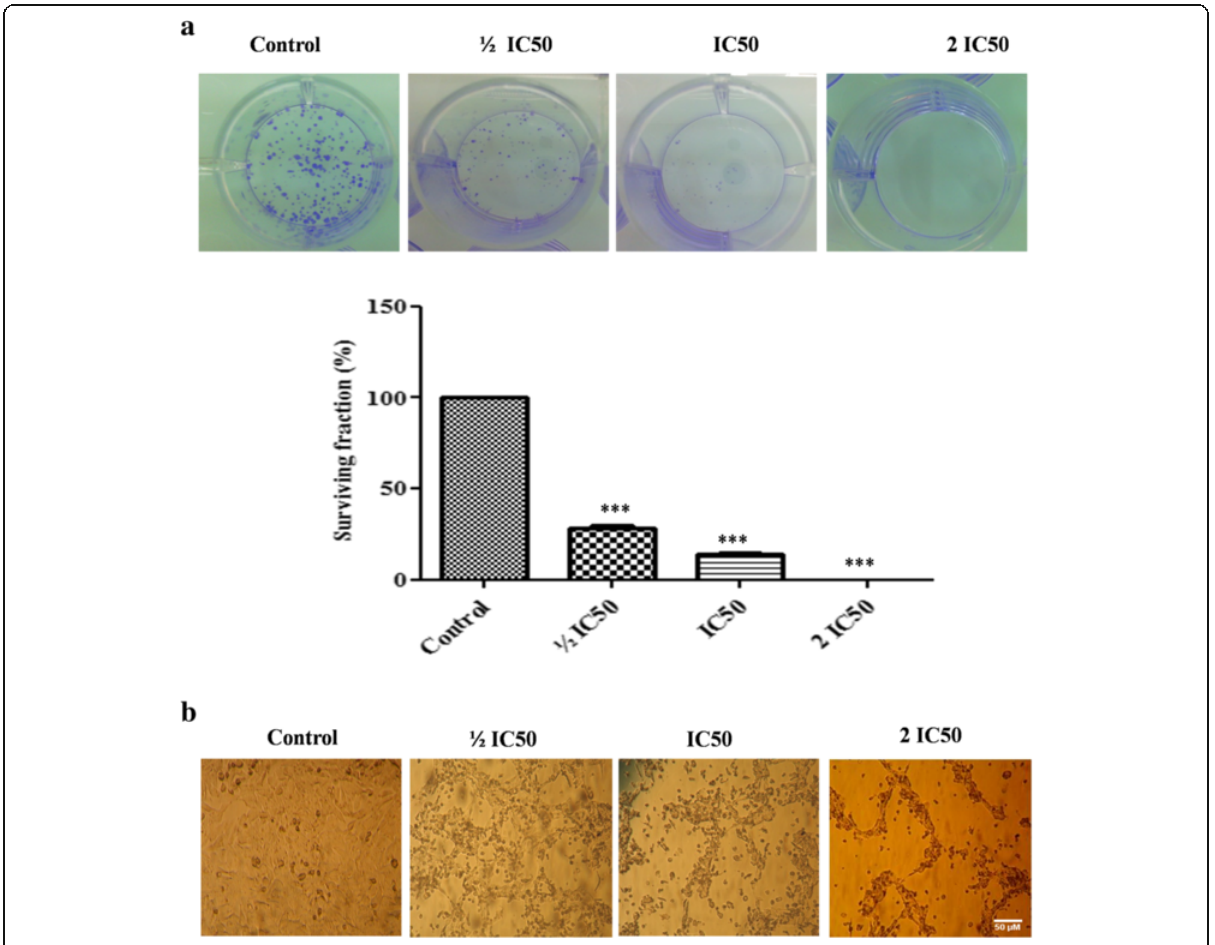
Fig. 3 Morphological and cell growth assessment of NCI-H358 cells treated with F3 fraction. a Decrease of colony number and inhibition of surviving fraction after cell exposure to ½ IC 50 , IC 50 and 2 IC 50 concentrations of F3 fraction. The data are expressed as the mean±SD of three independent experiments in triplicate. Significances are shown in comparison to control cells (*** p <0.001). b Morphological changes of NCI-H358 cells were observed under the phase contrast inverted microscope (magnification 100×) after the treatment with ½ IC 50 , IC 50 and 2 IC 50 concentrations of F3 fraction for 24